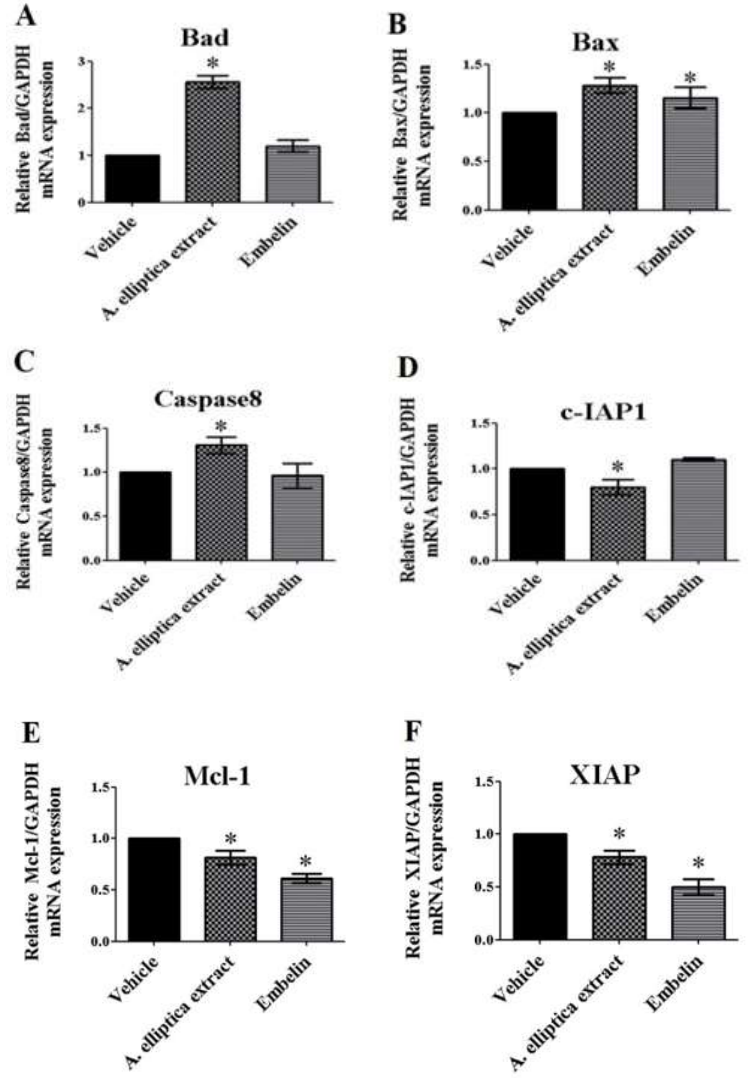
Figure 4. Effects of A. elliptica fruit extract and embelin on mRNA expressions of pro- and anti-apoptotic genes ( A – F ). Cells were treated with the vehicle (control), 10 µg/mL fruit extracts, or 20 µg/mL embelin for 12 h at 37 °C. After treatment, the total RNA was extracted from the cells, and the mRNA expression was analyzed using specific primers. The relative Bad ( A ), Bax ( B ), Caspase-8 ( C ), c-IAP1 ( D ), Mcl-1 ( E ), and XIAP ( F ) mRNA levels were quantified and shown as the mean ± SEM ( N = 3). * P < 0.05 versus vehicle.